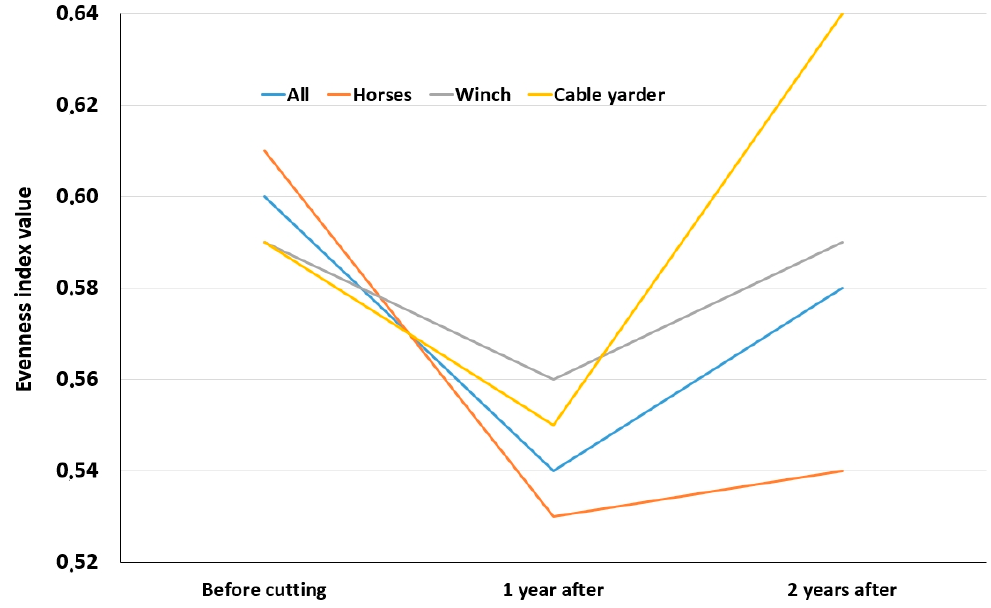
Figure 7. Floristic evenness index trend related to the different harvesting systems.